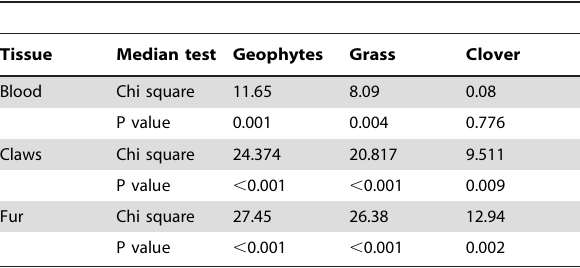
Table 6. Results of Median tests showing differences in dietary compositions between species (shown in Figure